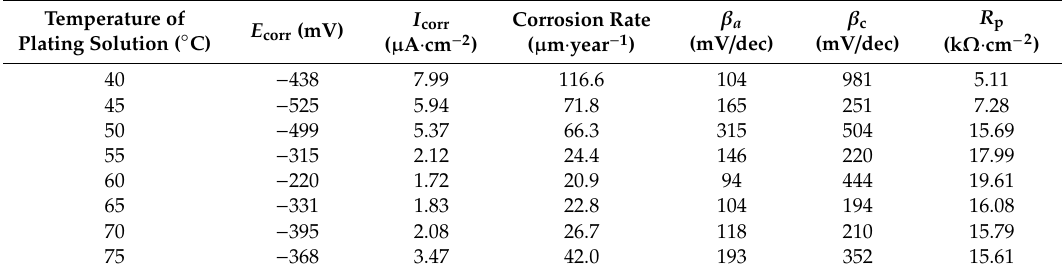
Figure 13. E ff ect of temperature of plating solution on polarization curves of Ni–Co–P alloy coatings in artificial seawater. Table 8. The corrosion potential ( E corr ), corrosion current density ( I corr ), and corrosion rate obtained from Figure